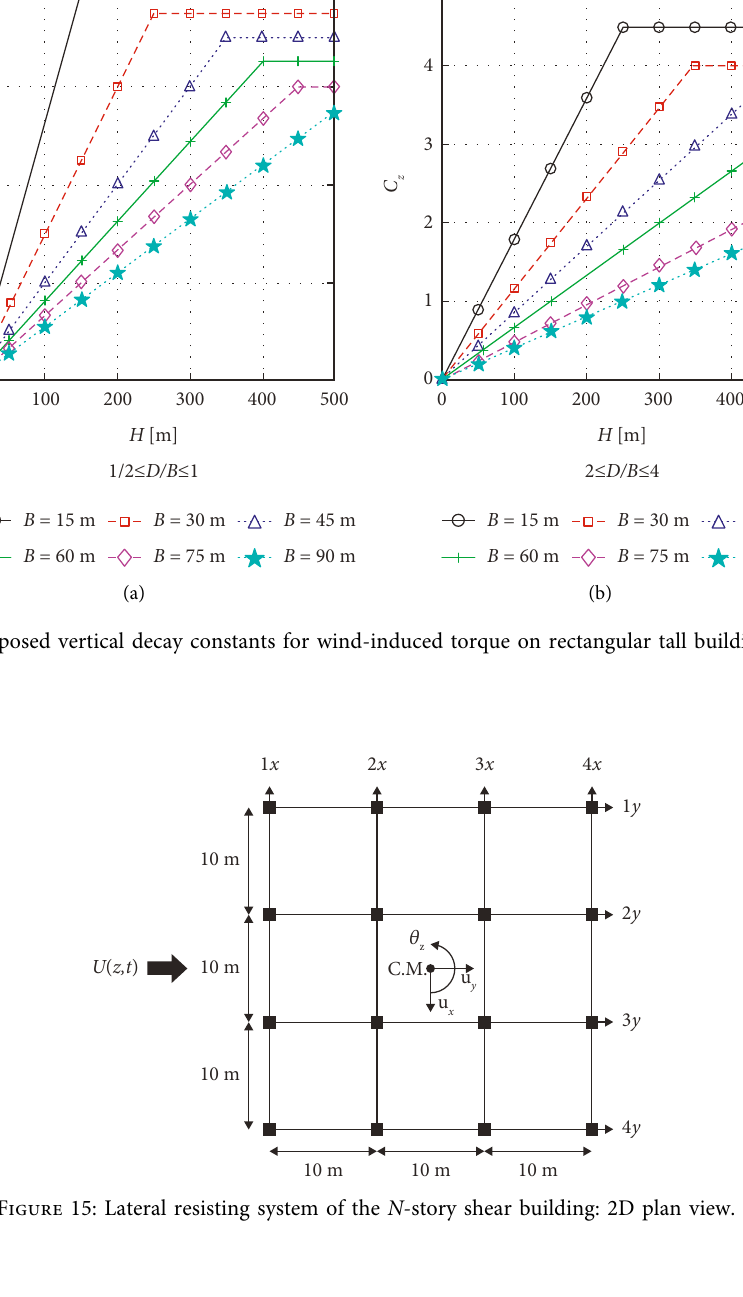
Table 3: Cartesian coordinates, angles, and projected distances of all shear frames.